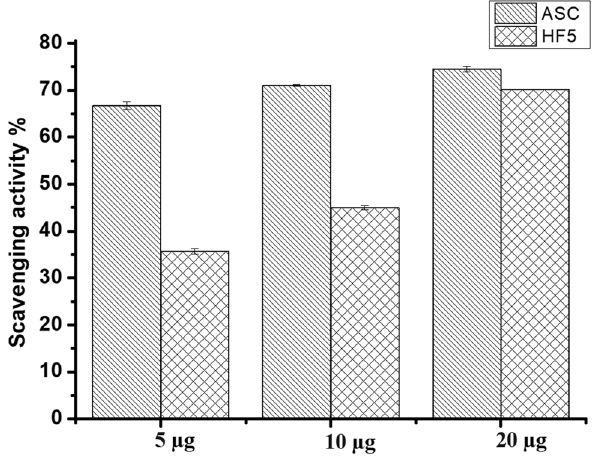
Figure 4: Antioxidant activity of PHF5 extracts. Antioxidant activity was assessed by measuring the reduction in DPPH radicals detected at 517nm. Ascorbic acid was used as a positive control. Results are presented as mean ± SD of three independent experiments. ASC: ascorbic acid, PHF5: polyherbal formula composed of fi ve plant